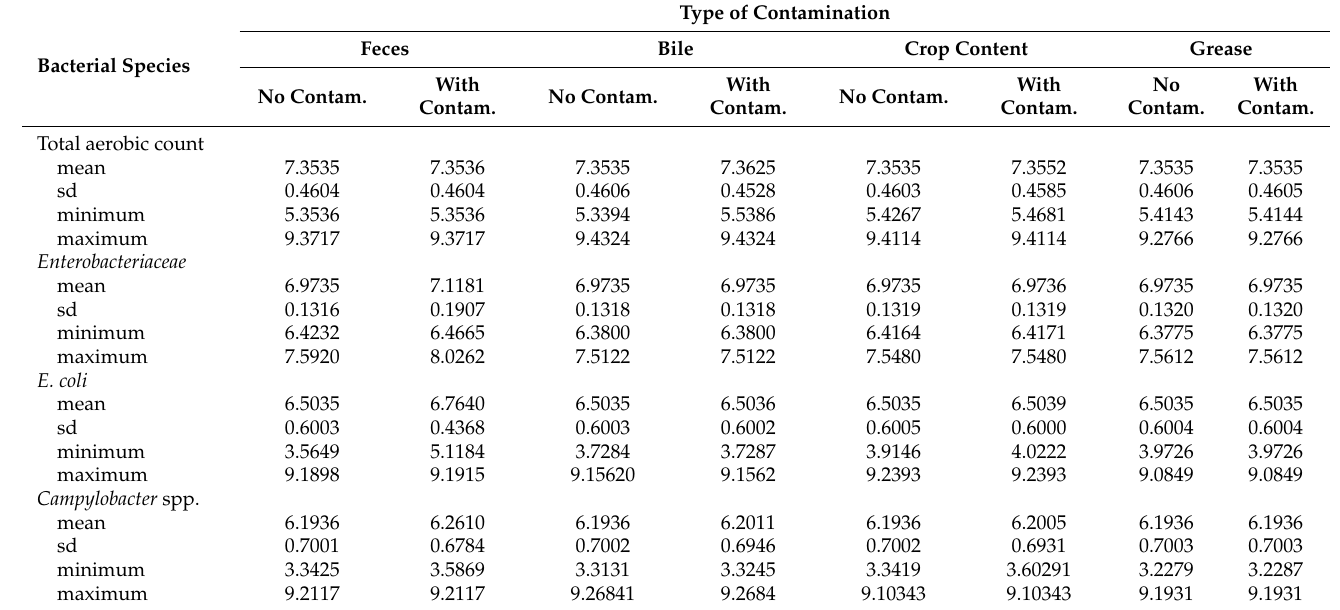
Table 3. Monte Carlo simulation of the total bacterial load on the average broiler carcass (1600 g) with or without a contamination with a small amount of material (expressed in log 10